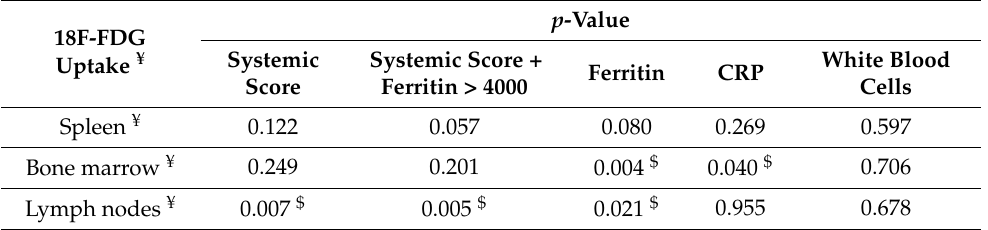
Table 3. 18F-FDG uptake results compared with clinical and biological disease